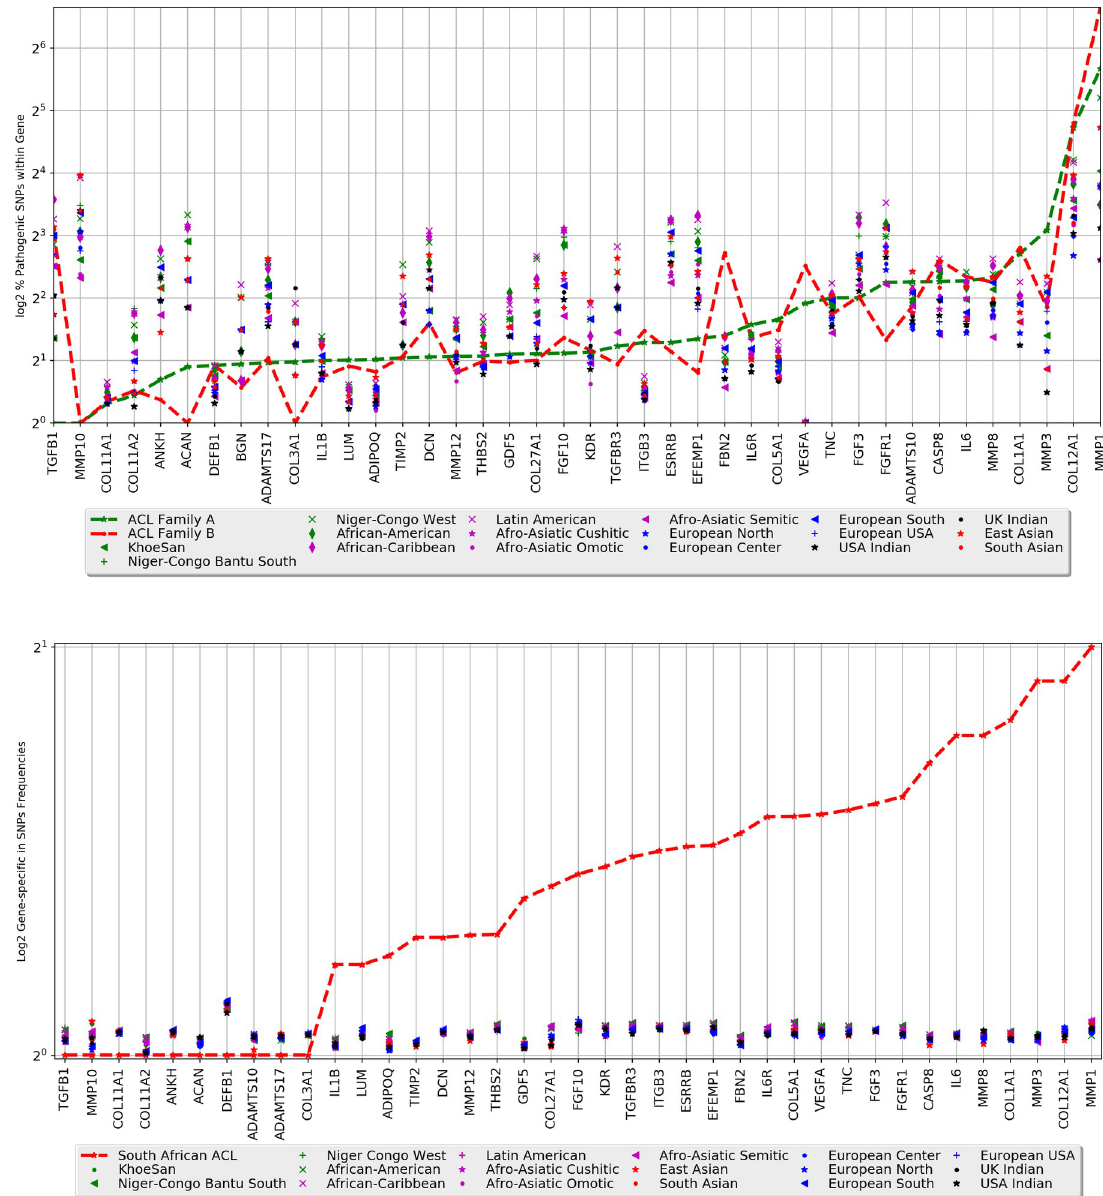
Fig 5. Biological sub-network of the candidate mutant genes with interacting genes in Family A (A) and Family B (B). Candidate genes common to Family A and B are highlighted by red stars. Weighting of interaction is depicted by line thickness. All query genes are given the maximum node size, and the size of related genes is inversely proportional to the rank of the gene based on its score assessed by GeneMANIA [19]. identical gene segment on chromosome 13q34 which included one gene, with the unaffected sister. In addition, Family A twins, their affected brother and Family B twins also shared the identical sequence for LINC01250 gene located on chromosome 2q25.3. And common to both families, both sets of twins shared the identical sequence for the 15q11.2 region comprising 8 genes, and the unaffected mother and affected brother from Family A shared the identical sequence for the KIR3DX1 (ENSG00000104970) gene with Twin 3 and 4 from Family B.